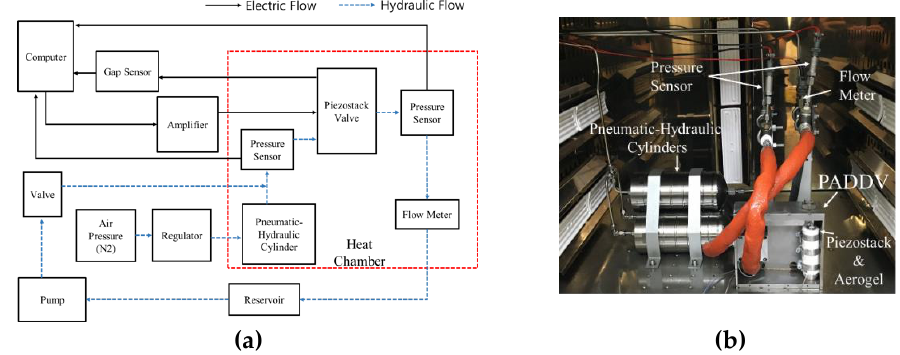
Figure 5. The flow chart and photograph of the experimental apparatus. ( a ) Experimental flow chart for the electric and hydraulic flow ( b ) PADDV installed in inside of the heat chamber.